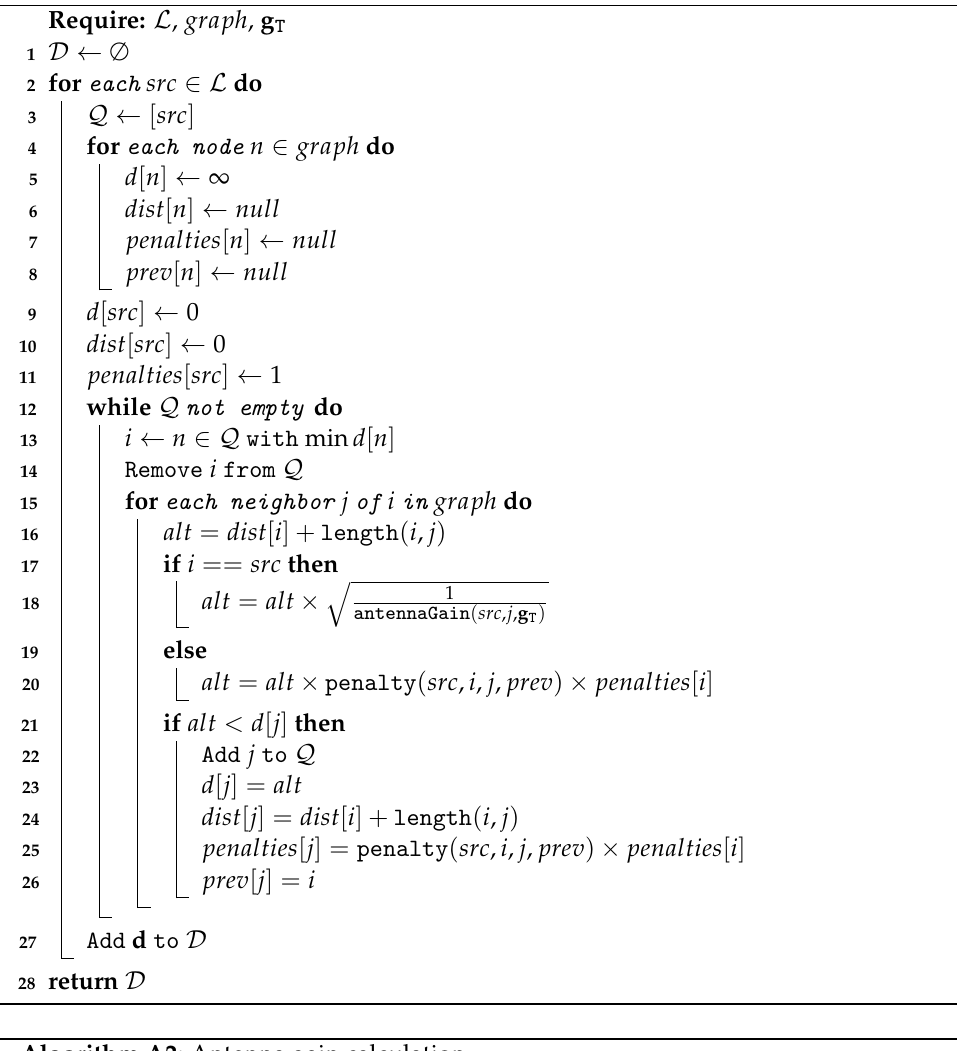
Algorithm A2: Antenna gain calculation.